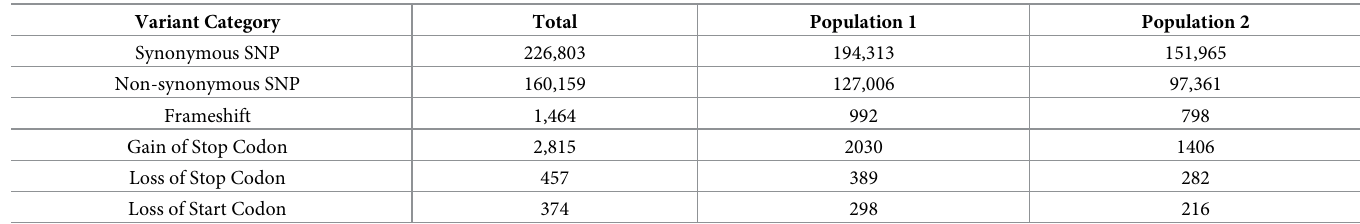
Table 1. Functional variants identified in a population of 197 P . nodorum